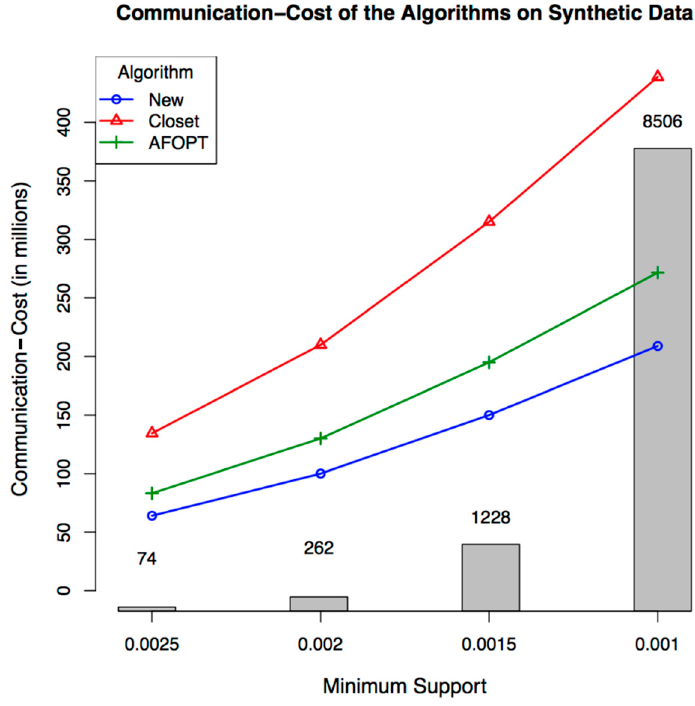
Figure 4. Communication–cost of the algorithms on synthetic data.